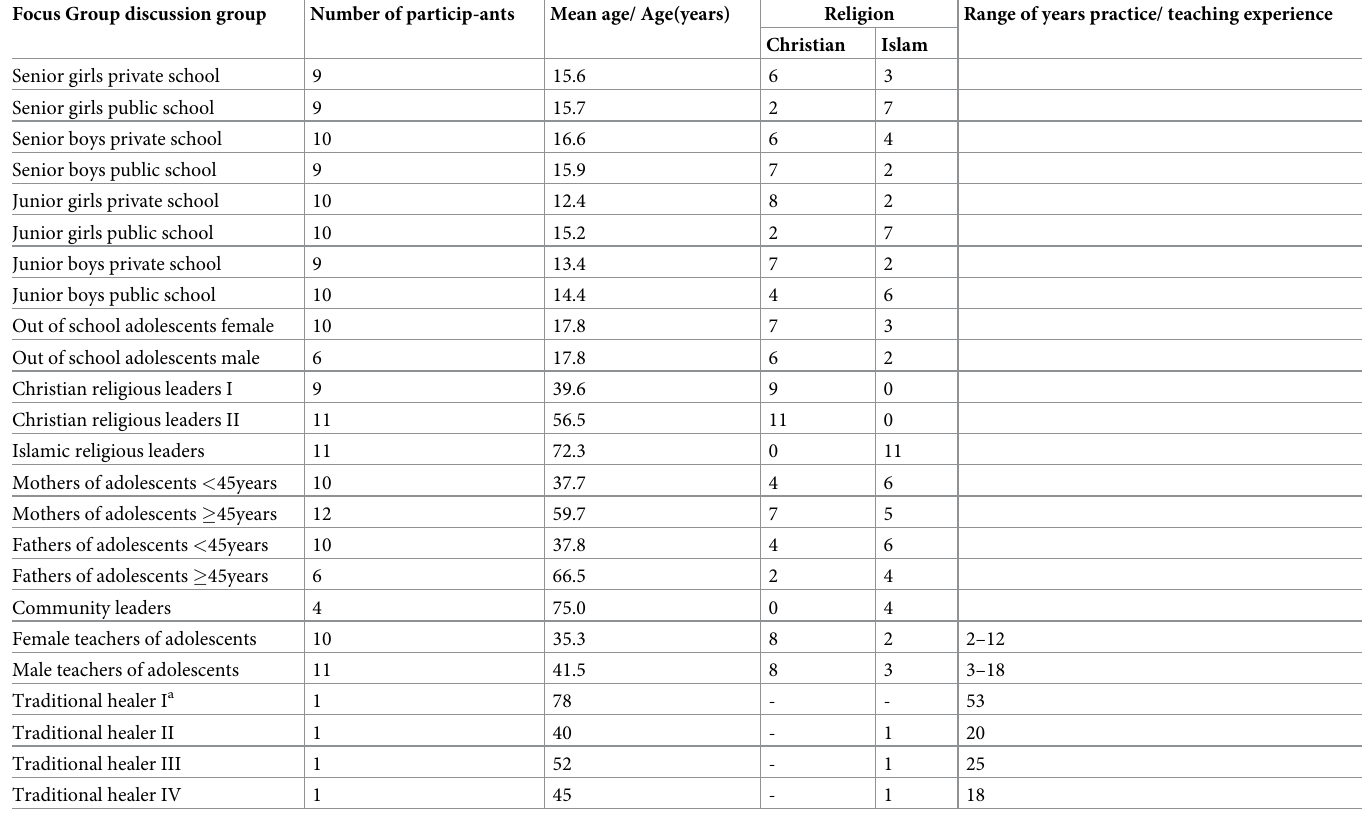
Table 1. Sociodemographic characteristics of the study